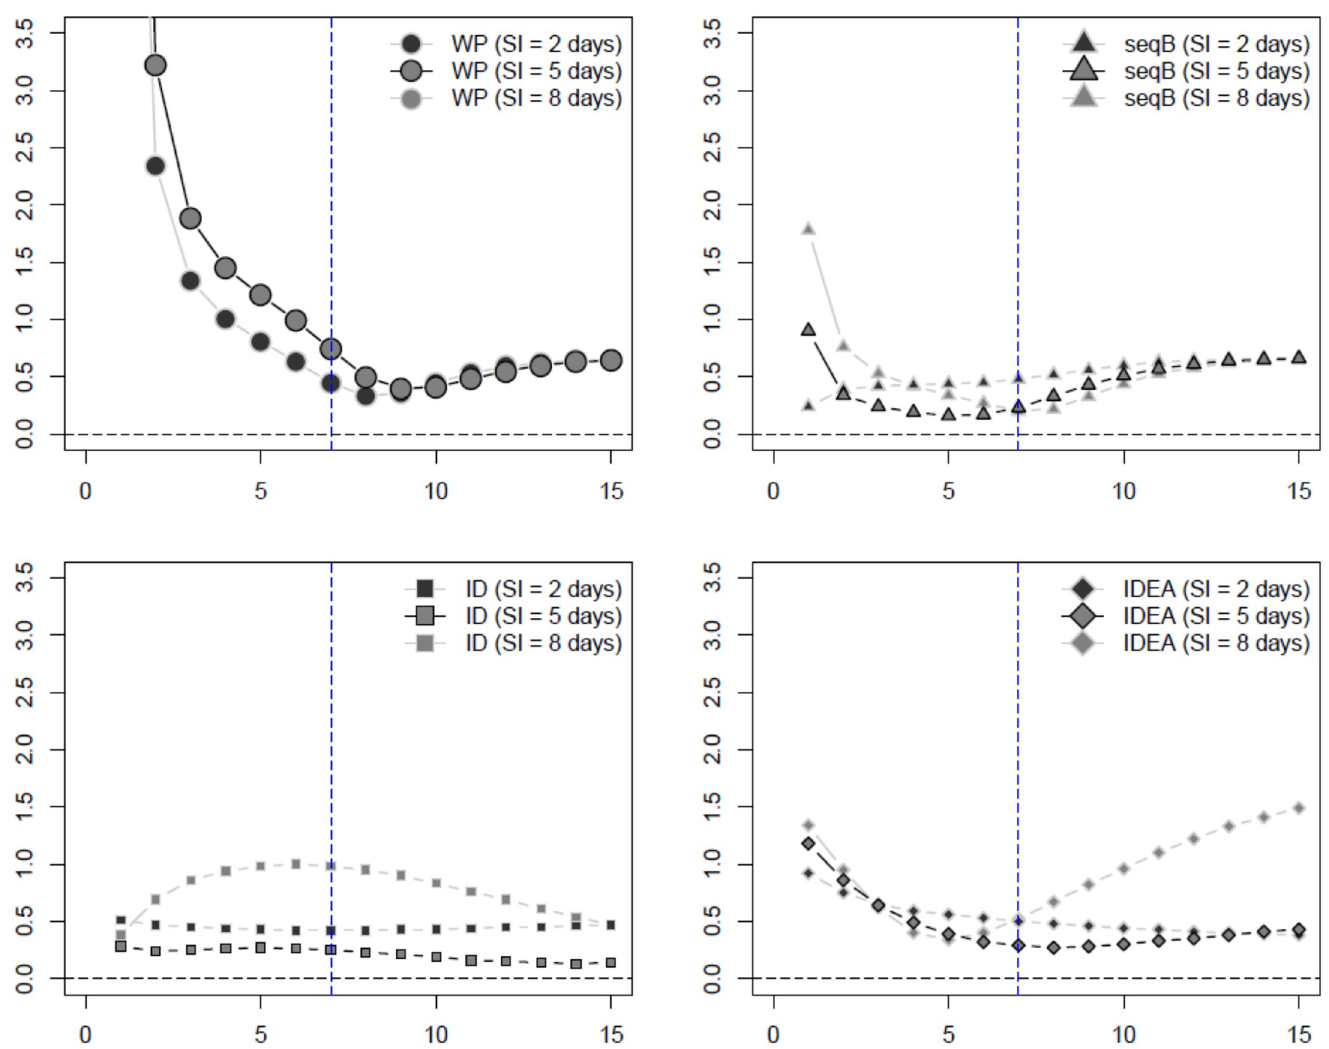
Fig 2. Influenza example 1 estimated MSE of R 0 estimators assuming known serial interval (SI) with SIR data (week on x -axis). The inflection point indicated by the blue dashed vertical line.